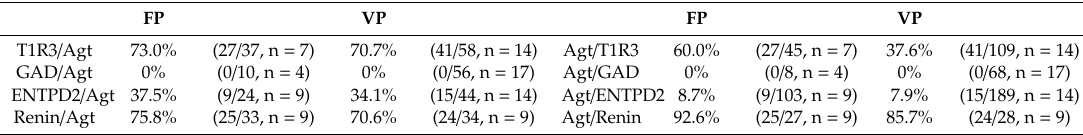
shown in green. The last merge panels: Nomarski images were overlaid with immunofluorescence (or GFP) merge images. Arrows indicate Agt-expressing taste cells that co-express T1R3, ENTPDase2, or renin. Dotted lines indicate the outlines of taste buds: scale bar, 25 μ m. Table 3. Co-expression ratio of Agt and taste cell markers in fungiform (FP) and circumvallate papillae (VP) in mice.